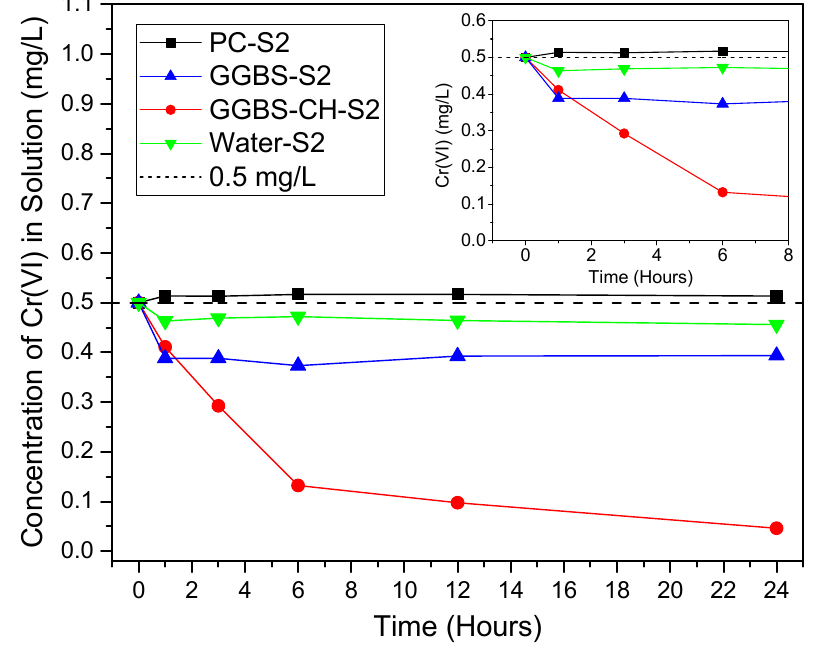
Figure 2. Time profile of the Cr(VI) concentration in the S2 specimens’ solutions from 0 to 24 h.